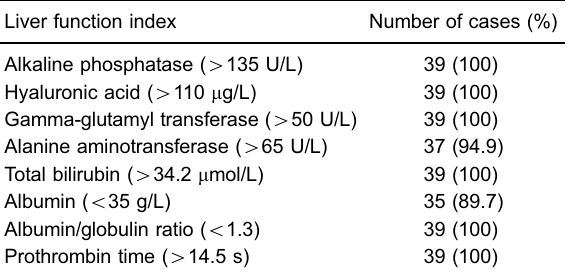
Table 2. Liver function test results for 39 patients with hepatic veno-occlusive disease who were positive for hepatitis B surface